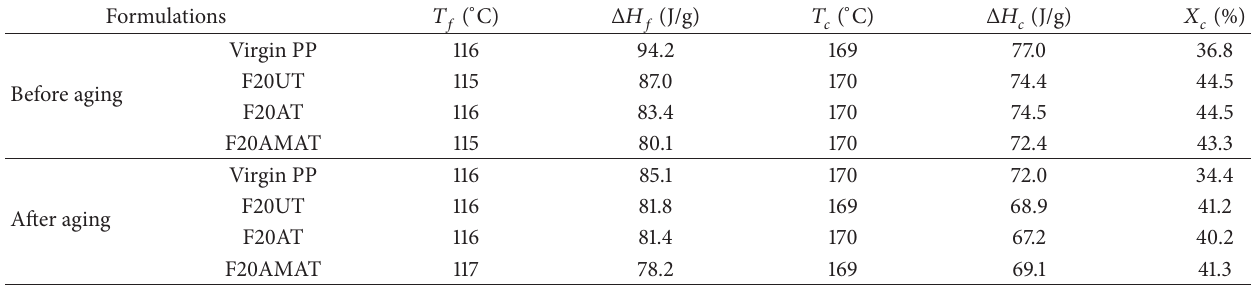
Table 3: Crystallinity rates of neat PP and PP/alfa fiber composite